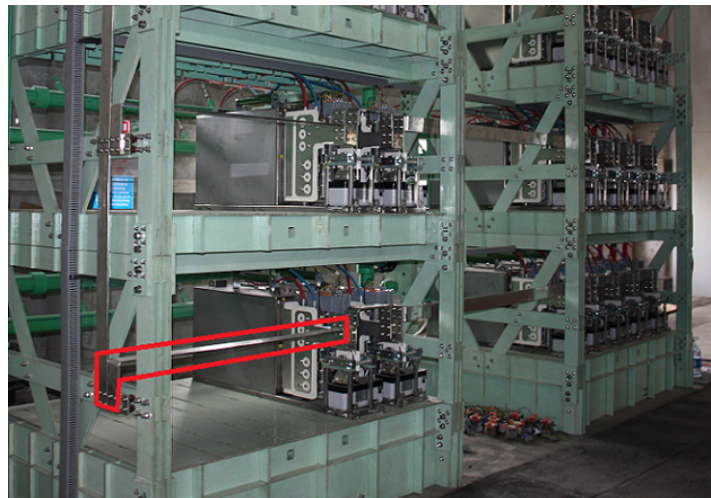
Figure 7. Long busbar removed from the valve.